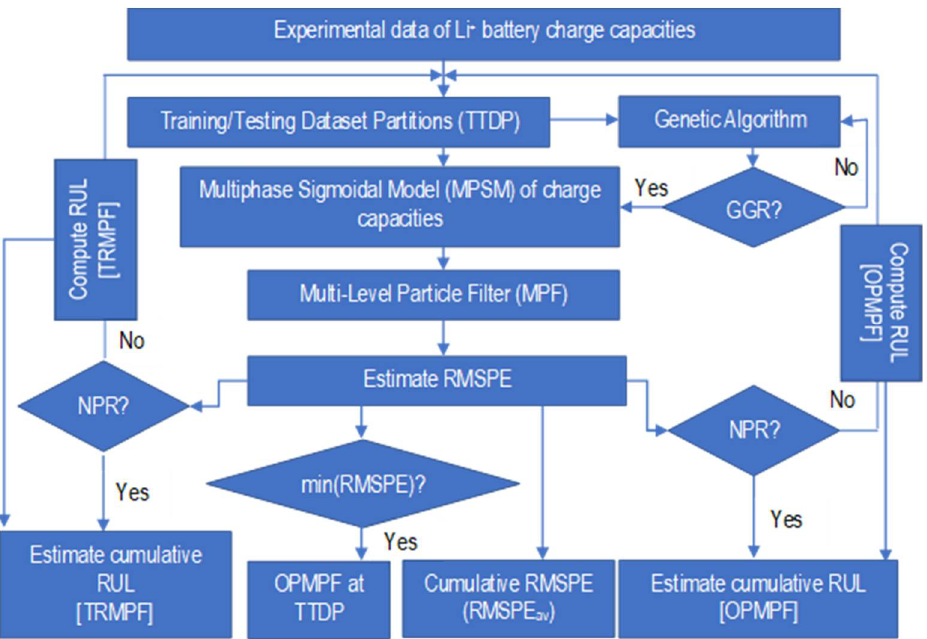
Figure 3. Summary of the experimental results of the lithium-ion battery charge capacity.